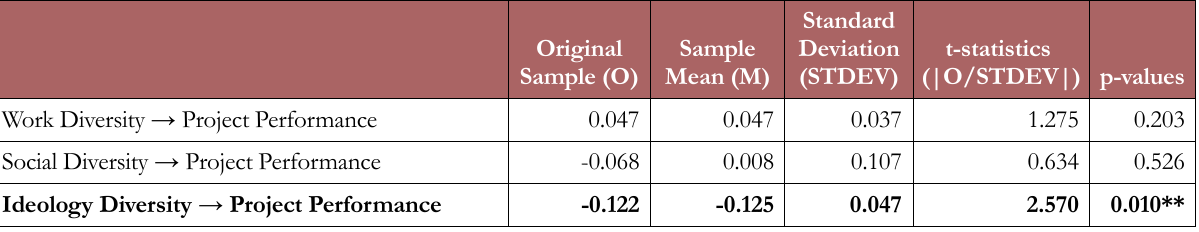
Table 11. Total Indirect Effect